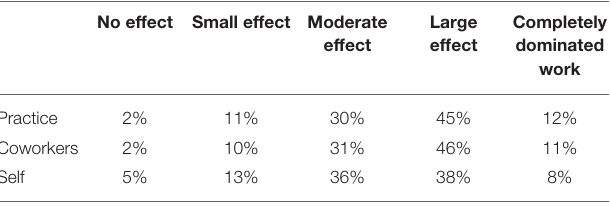
TABLE 1 | Veterinary technicians’ perceptions of the extent of the effect of COVID-19 on work for their practice, coworkers, and selves.